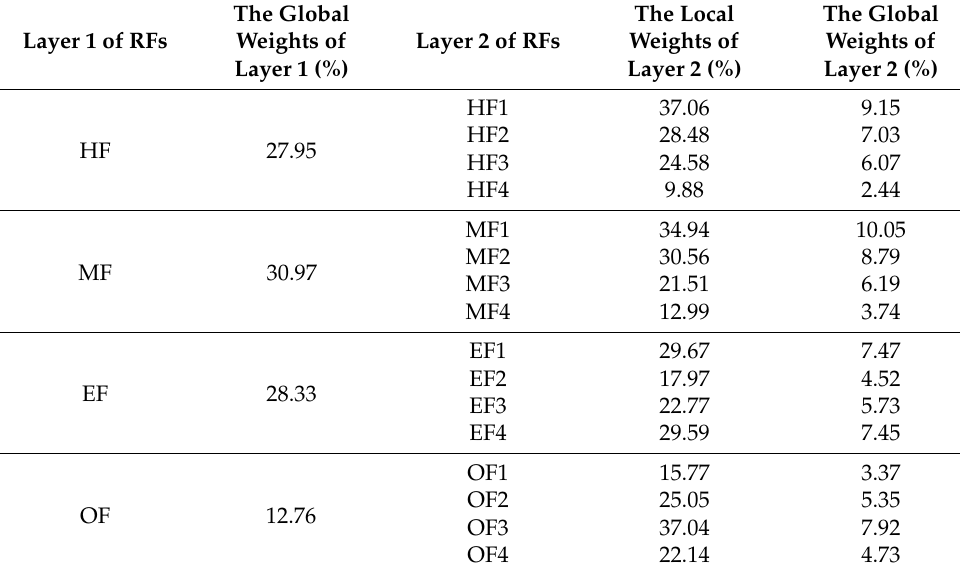
Table 5. The consequence weights of